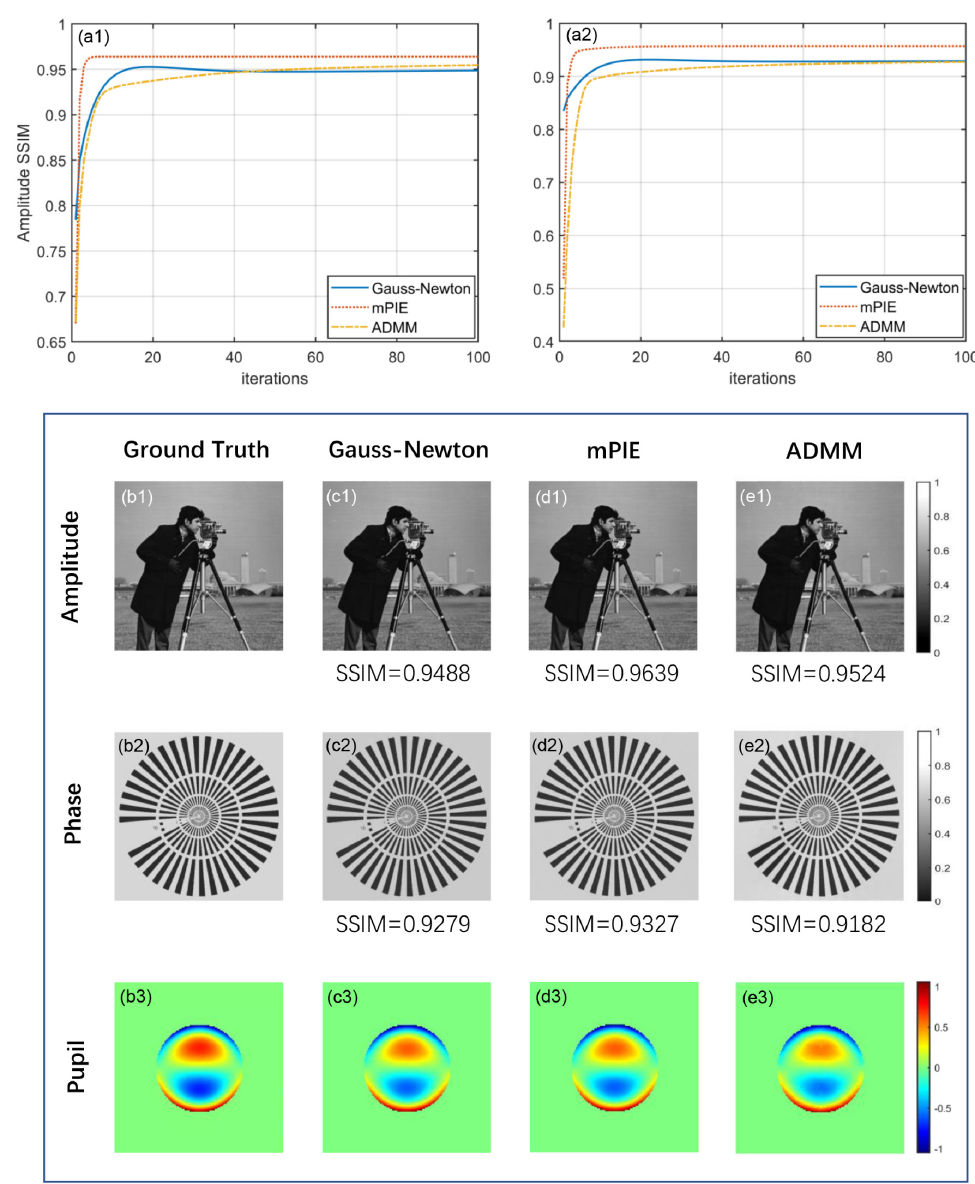
Figure 2. Comparison of simulated reconstruction results under noiseless conditions. ( a1 , a2 ) Amplitude and phase SSIM curves for 100 iterations. ( b1 – b3 ) Simulated ground truth of amplitude, phase and pupil for FPM reconstruction. Corresponding visual reconstruction results: ( c1 – c3 ) Gauss–Newton method. ( d1 – d3 ) mPIE algorithm. ( e1 – e3 ) ADMM method.